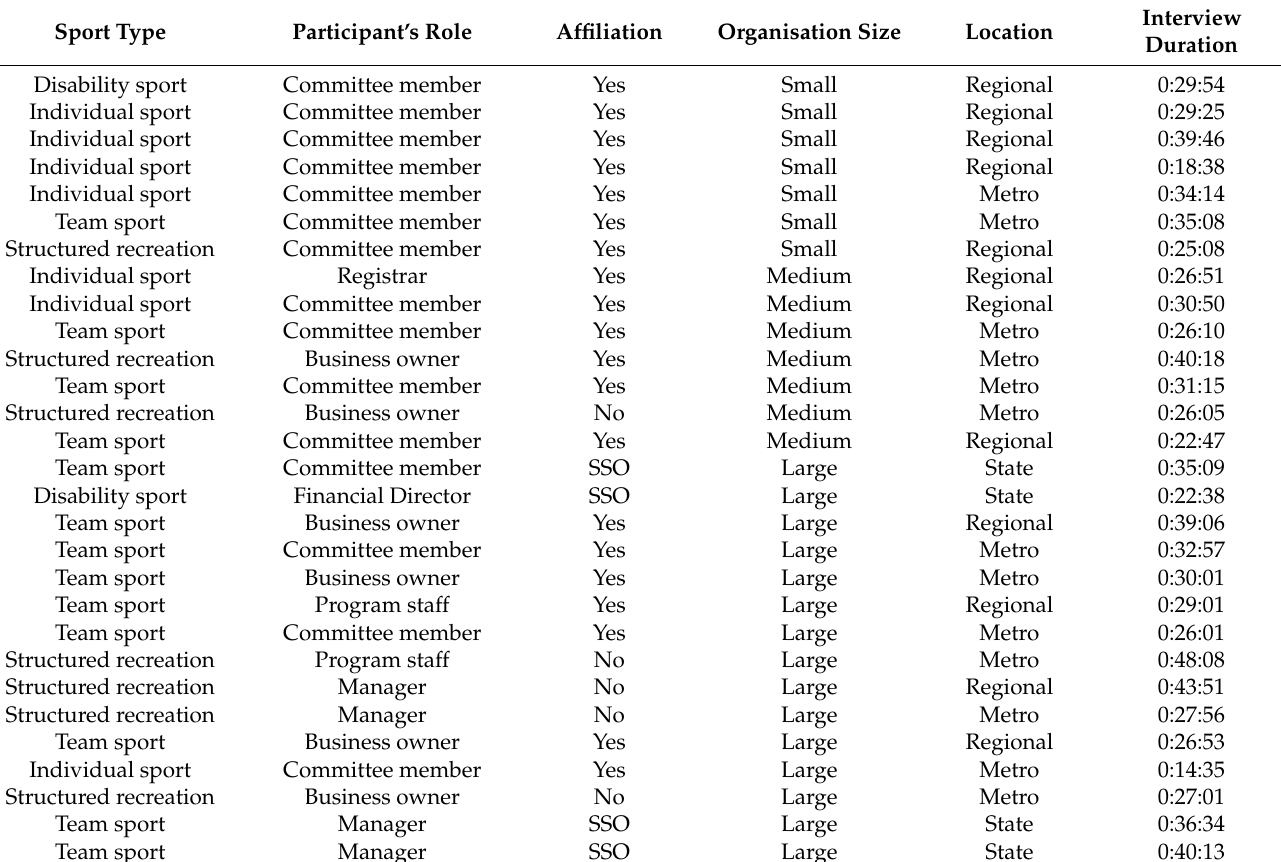
Table 1. Interview participant